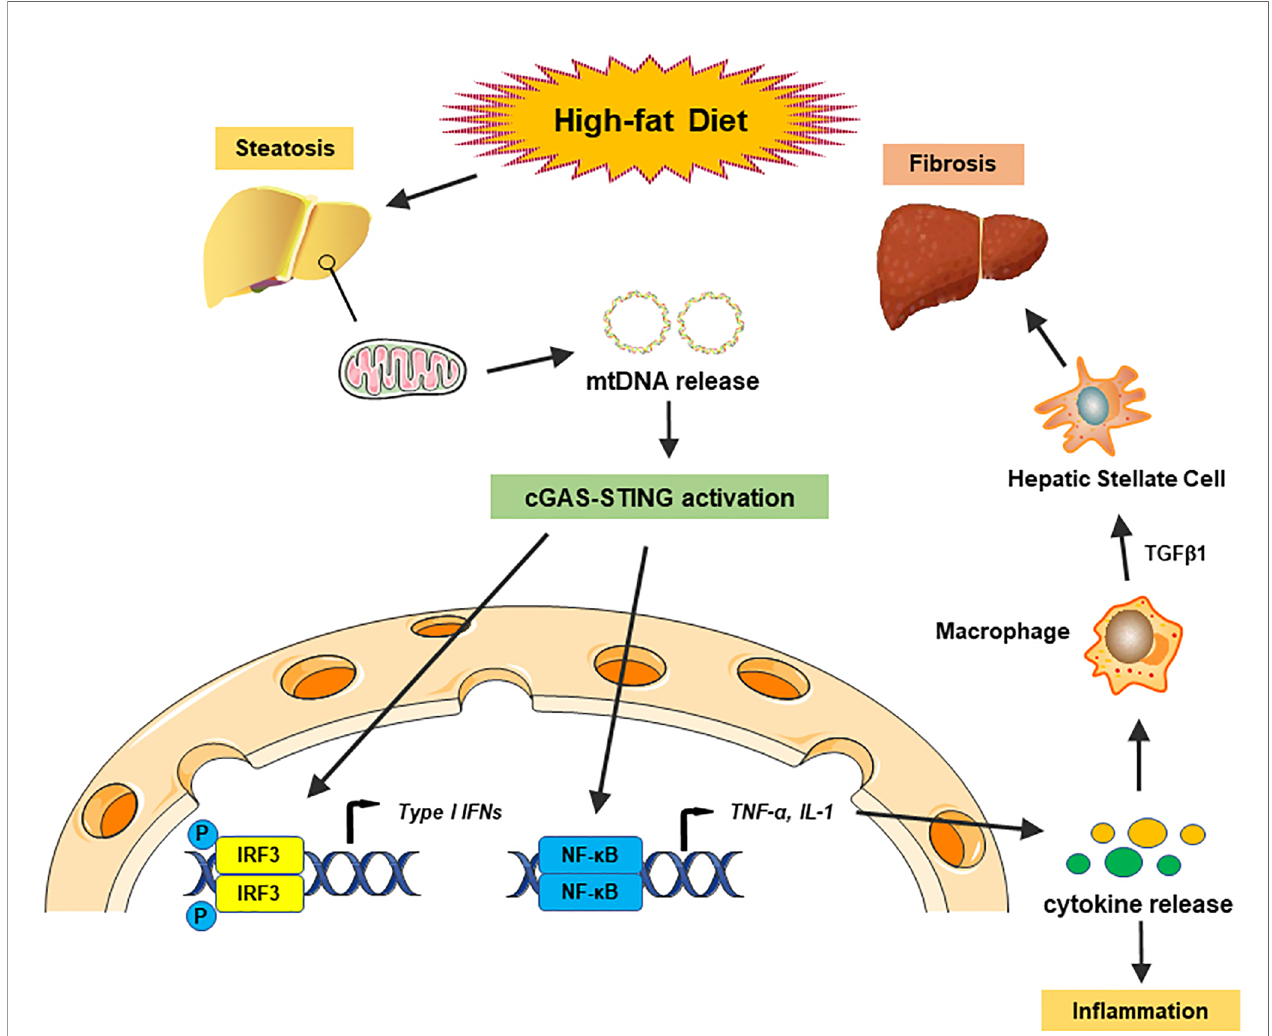
FIGURE 2 | The cGAS-STING pathway in nonalcoholic fatty liver disease. A high-fat diet (HFD) causes steatosis, which induces mitochondrial stress damage in hepatocytes and subsequent releases of mitochondrial DNA (mtDNA) into the cytosol. Cytosolic mtDNA is recognized as an endogenous DAMP, which activates the cGAS-STING pathway and induces the IRF3 signaling to promote transcription of type I IFNs. Activation of the cGAS-STING pathway also induces the NF- k B signaling to produce proin fl ammatory cytokines, which triggers hepatic in fl ammatory responses. Moreover, proin fl ammatory cytokines activate macrophage function and produce TGF- b 1, which activates hepatic stellate cells (HSCs) and promotes liver fi brosis in